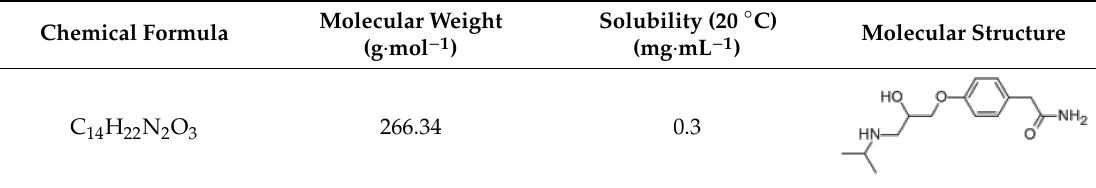
Table 1. Molecular structure of ATL.